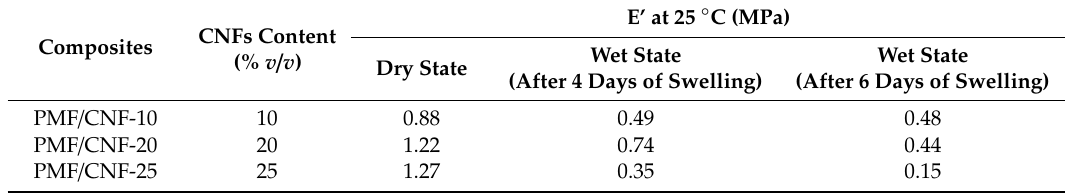
Table 1. Dynamic mechanical properties of dry and water swollen films of PMF / CNFs composites at 25 ◦ C.